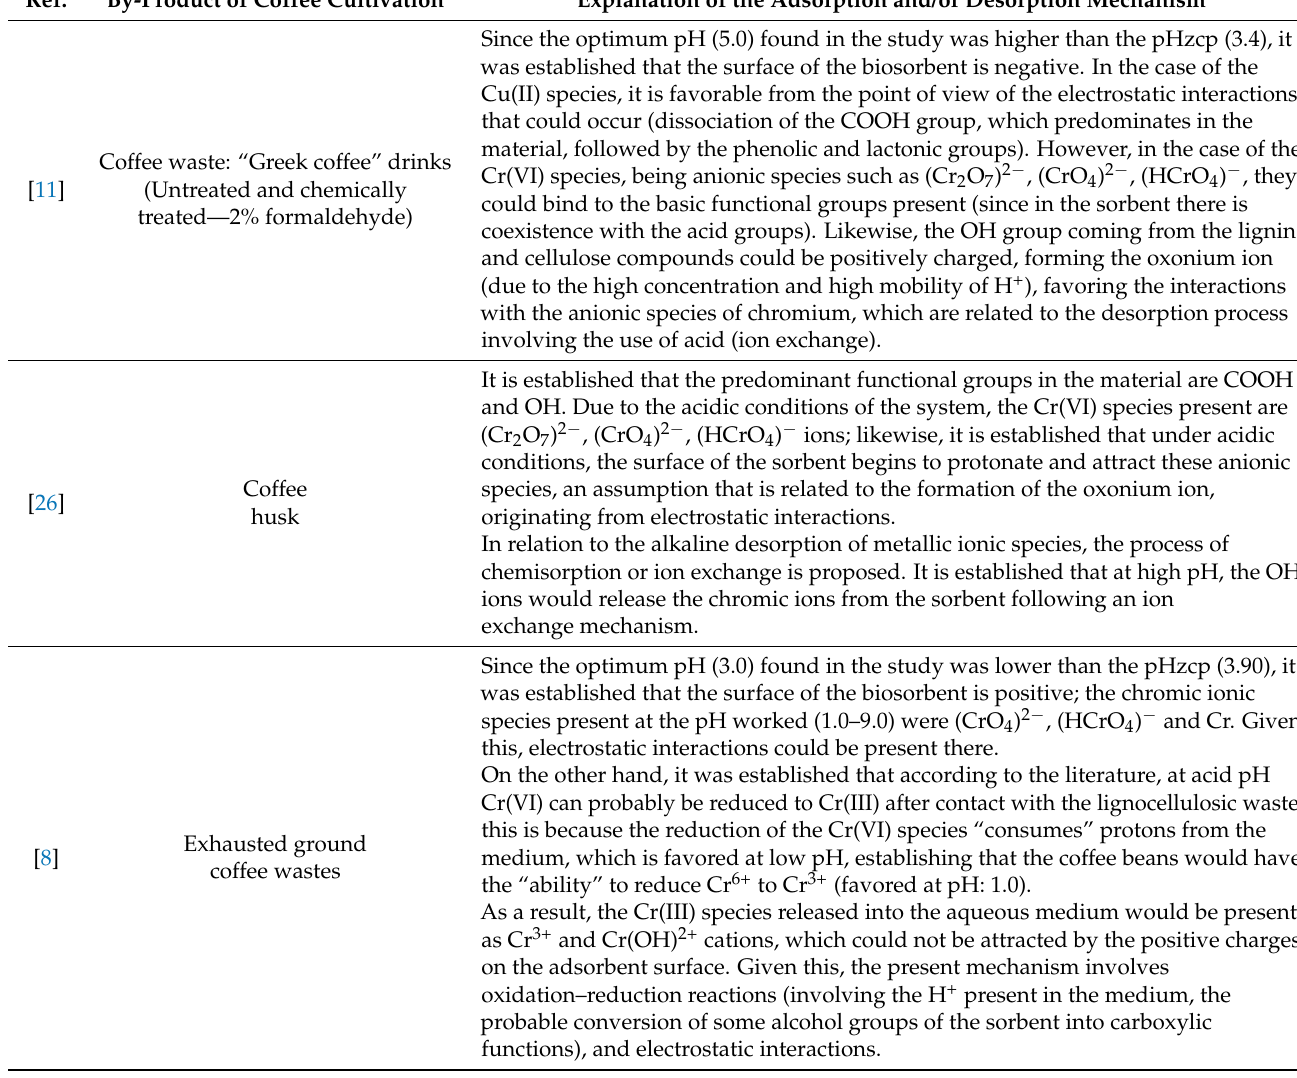
Table 6. Statements reported on possible adsorption and desorption mechanisms using coffee by- products as